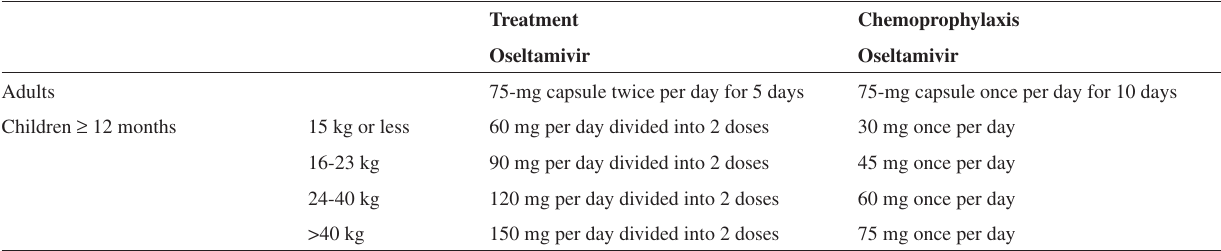
Table 1 - Recommended antiviral treatment and prophylaxis for novel influenza A (H1N1) infection